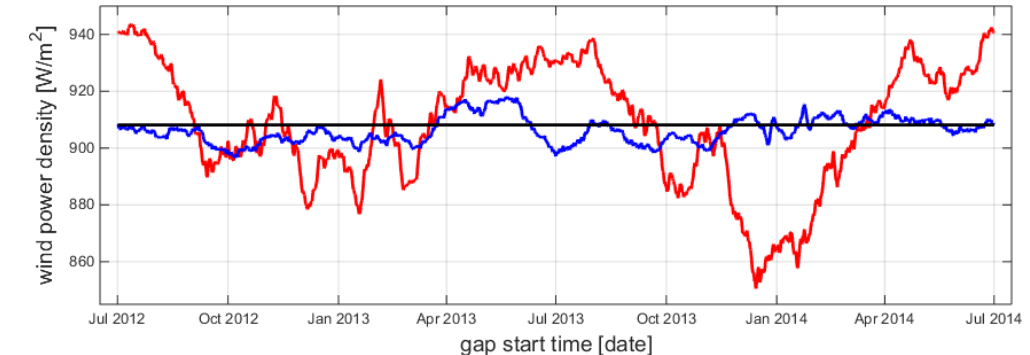
Figure 12. Variation in wind power density (WPD), as an alternative statistical measure to those shown already in Fig. 6 for the FINO3 site, depending on start date of artificial gap – here for a gap length of 30d, for incomplete time series in red and for filled time series in blue. Wind statistics for original time series are in black as